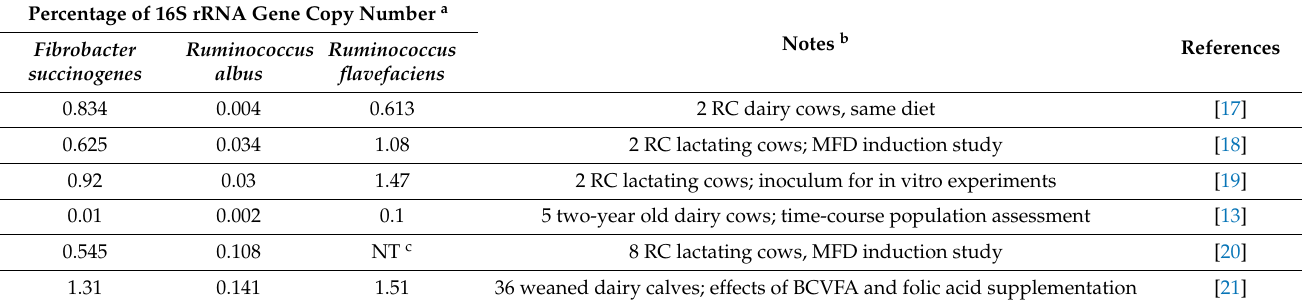
Table 1. Relative abundance of predominant ruminal cellulolytic bacteria in the rumen, determined using quantitative polymerase chain reaction